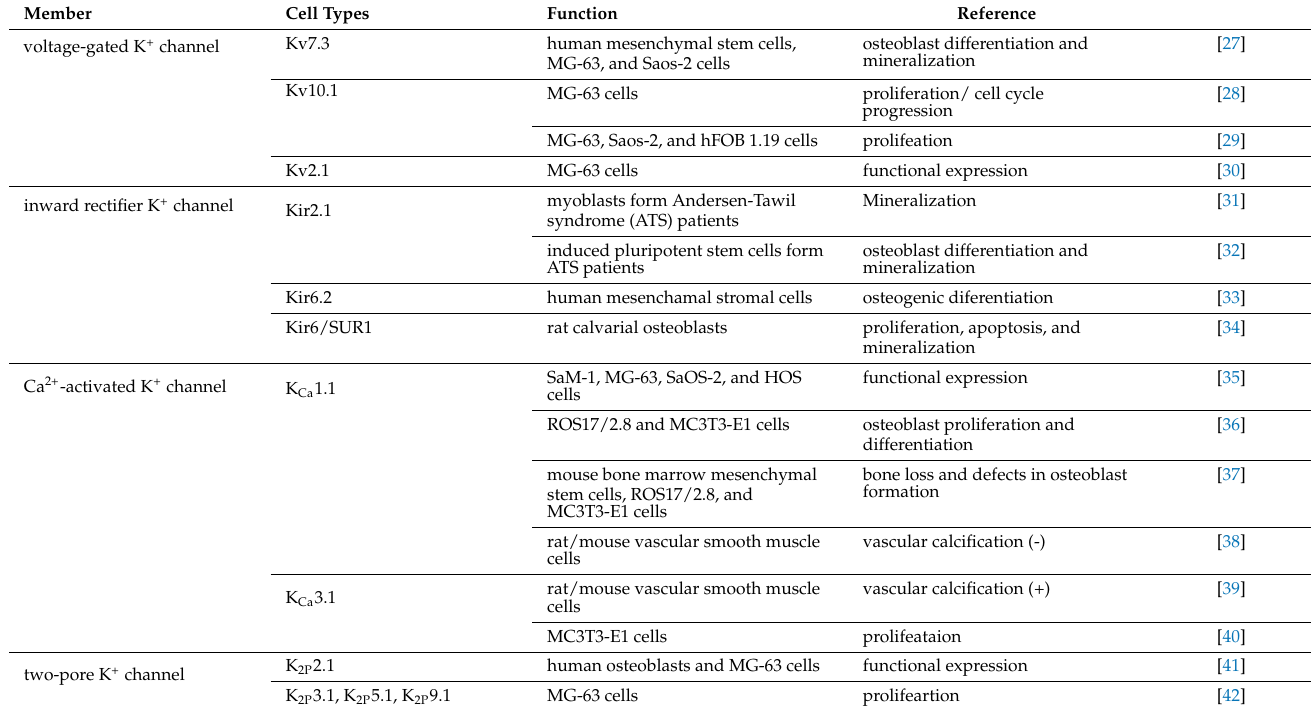
Table 1. Functional expression of K + channels in osteoblast lineage